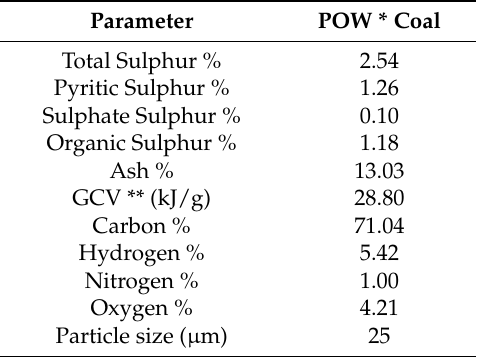
Table 1. Analysis of the untreated